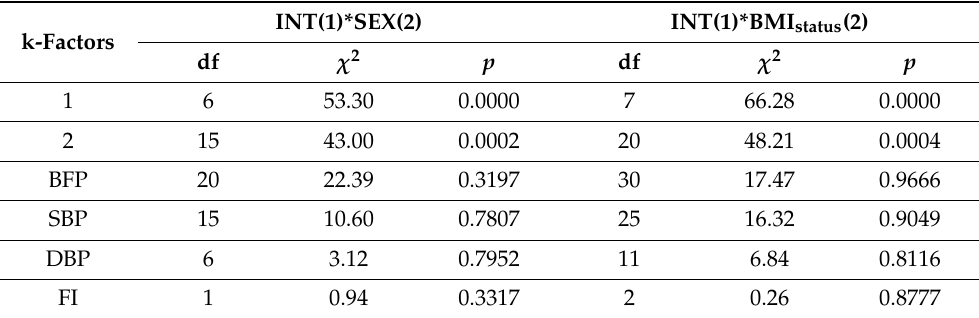
Table 3. Test results of interactions between factors (1–2) and dependent variables (BFP, SBP, DBP, and